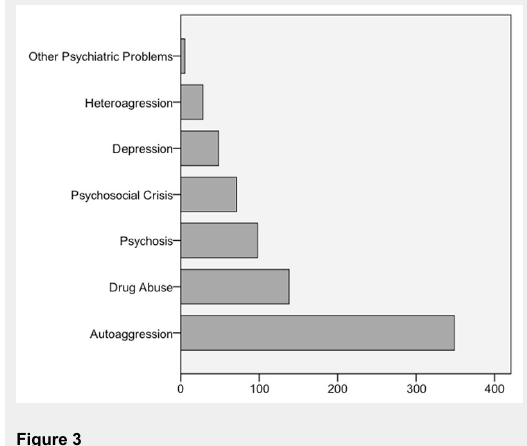
Summary of admissions for psychiatric diseases (number of patients per